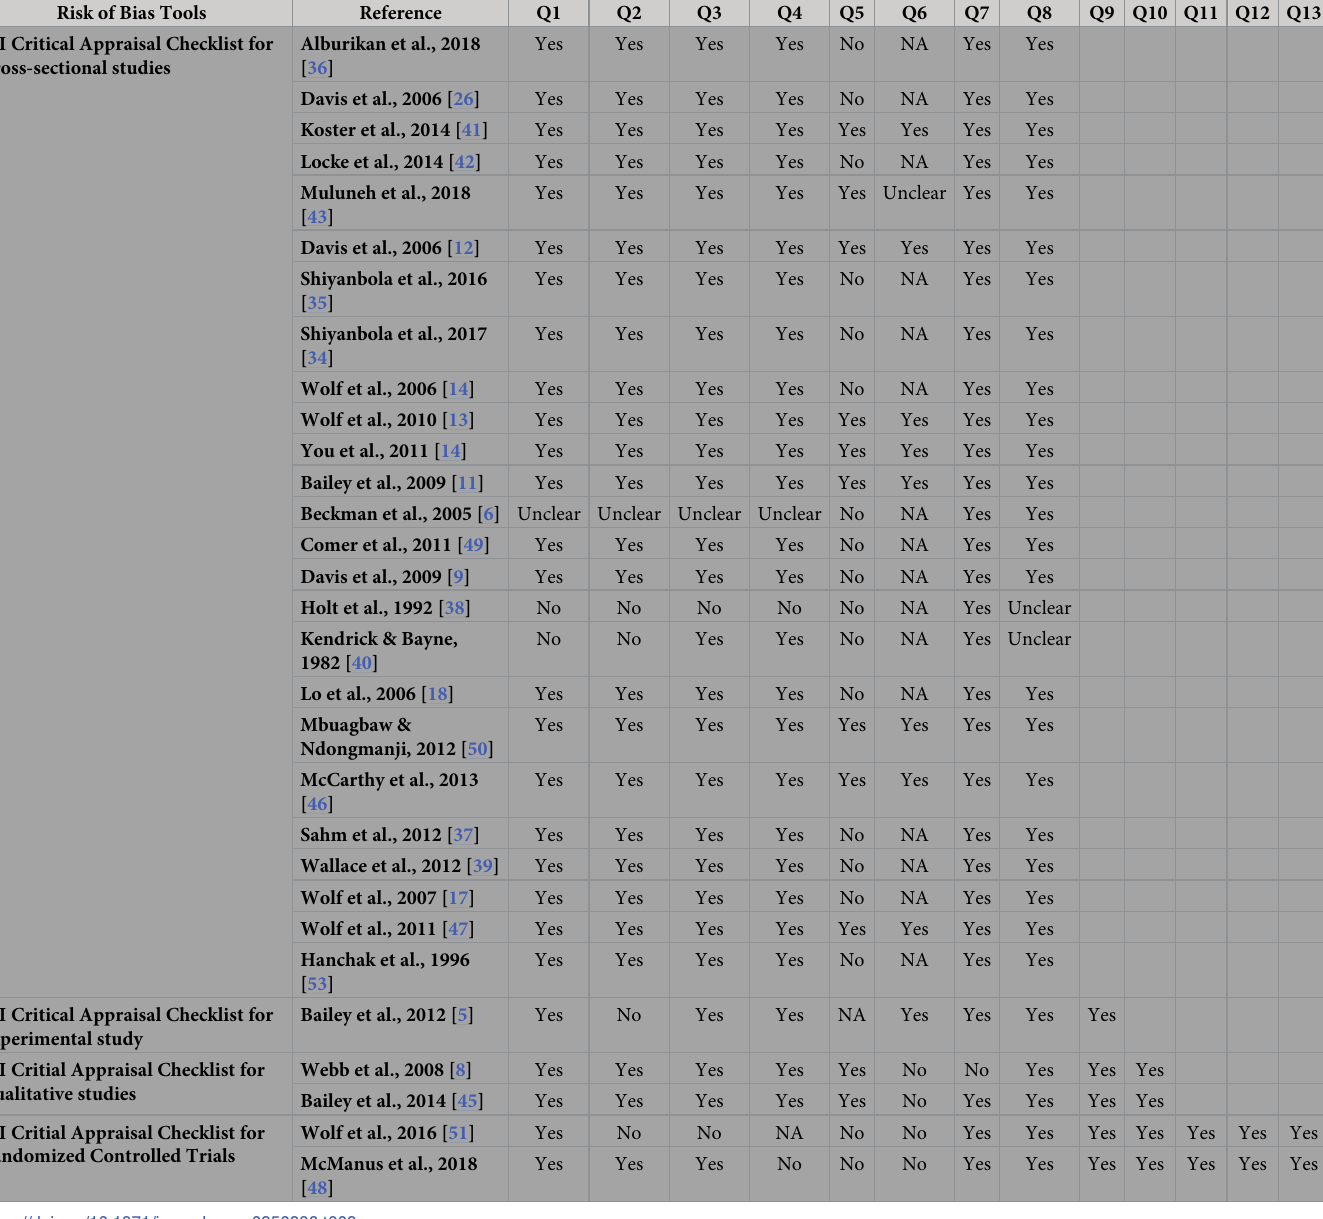
Table 2. Assessment of the methodological quality of the included publications using the JBI critical appraisal checklists. Risk of Bias